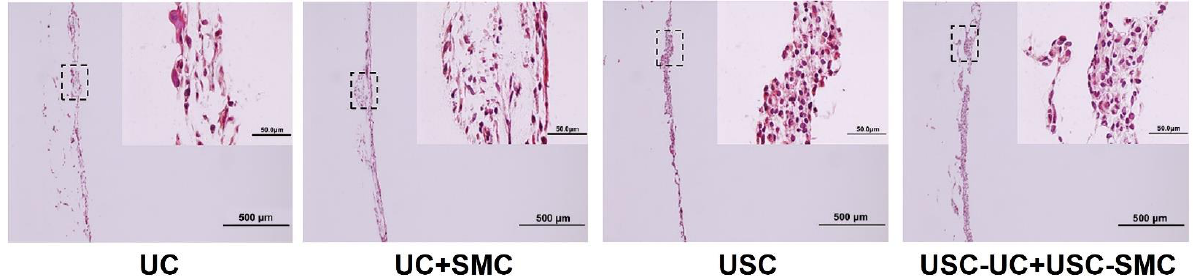
Figure 5. Cell sheets formed under 3D dynamic culture. The co-culture of USC-induced UC and SMC under 3D dynamic conditions gave rise to cell sheets with up to 14 layers and denser structure, compared with USC or UC alone, assessed by Masson’s trichrome staining. Abbreviations: USC, urine-derived stem cells; UC, urothelial cell; SMC, smooth muscle cell. The images are adapted from Biomaterials [16] with permission. (License number: 5292510480483). To optimize the regeneration of the urothelial tissues, a favorable cell source and scaffold has to be carefully selected. Various cell types have been evaluated for urological tissue engineering, including autologous UC [7,65,66,110–113], epithelial cells originating from buccal mucosa [114], embryonic stem cells (ESC) [40], induced pluripotent stem cell (iPSC) [40], BMSC [7], and adipose-derived stem cells (ASC) [115]. However, obtaining these cells requires either invasive procedures (i.e., BMSC) or costly methods (i.e., iPSC). Thus, an easily assessable and largely expandable stem cell source is needed. Similarly, var- ious options have been developed for the scaffold materials, including porcine xenografts, scaffolds [6]. Ideal scaffolds should have porous microstructures but the best combination of structural integrity, integration with preferred cell types, and functional development of physiological normal